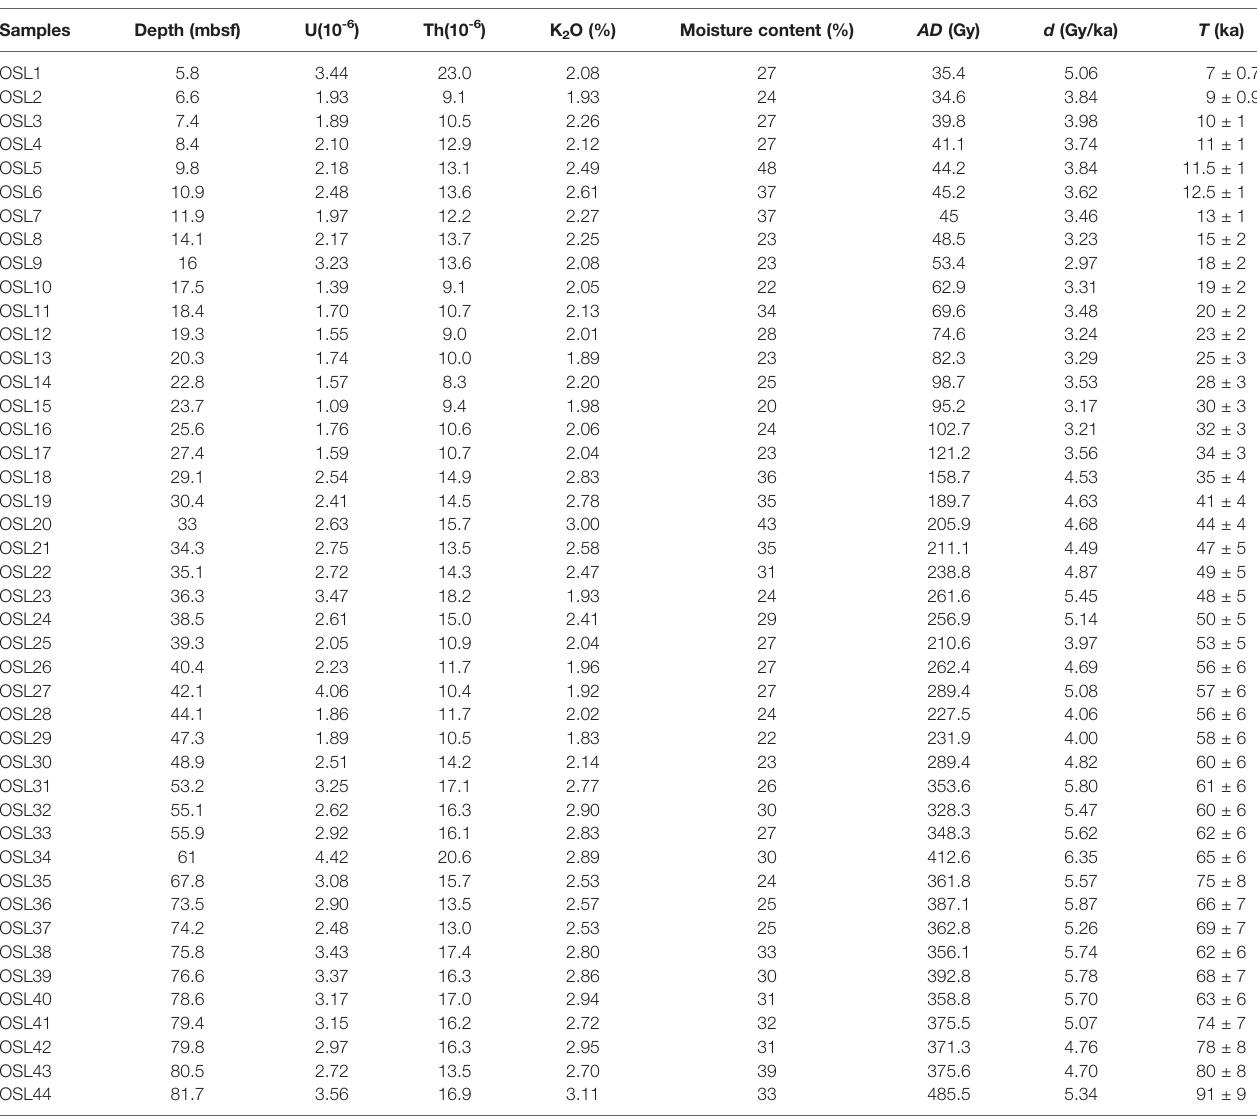
TABLE 2 | The OSL dates of selected samples from borehole SFK-1. Samples Depth